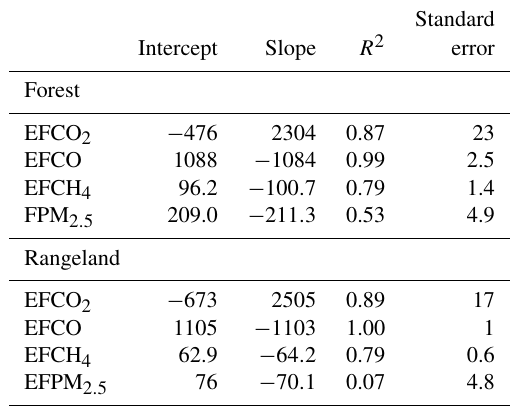
Table 8. Statistics for the linear regression of EF as a function of MCE for field data from 78 forest fires and 20 rangeland fires (Ta- ble S4 and Figs. S1 and